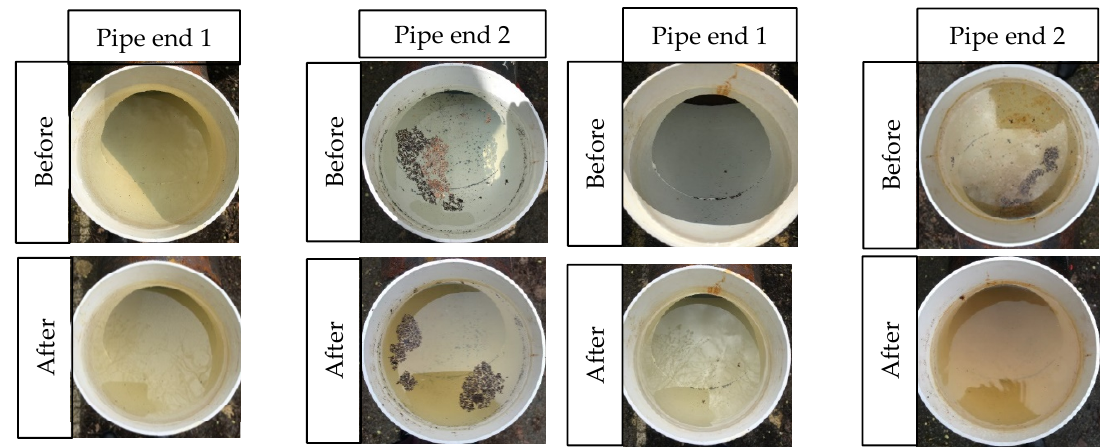
Figure 9. ( a ) Marinized HPUT with marinized cabling and ( b ) marinized HPUTs placed into prototype HPUT collar to commence laboratory investigations.